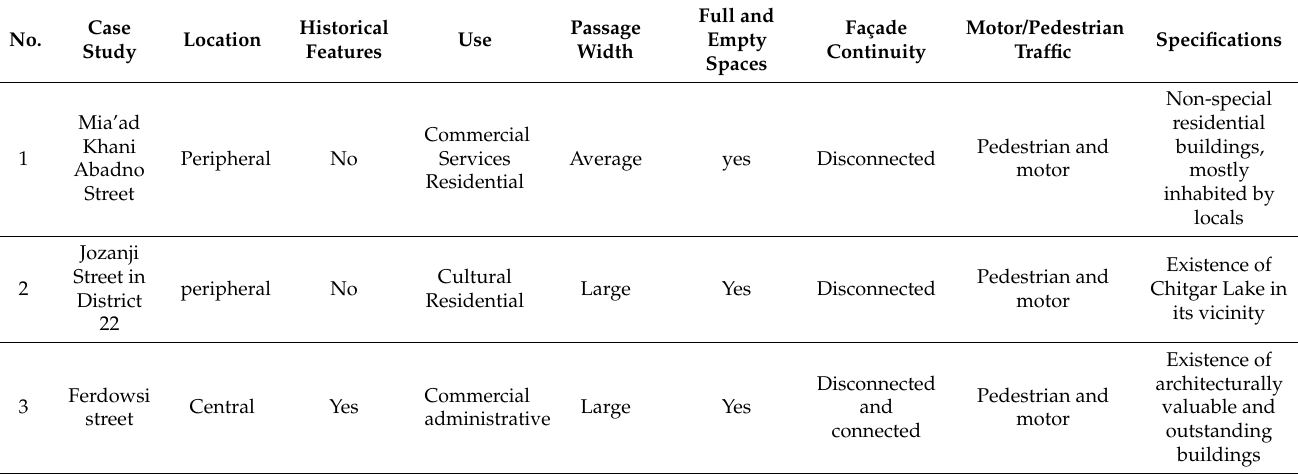
Table 4. Specifications of the case studies (Source: Authors,